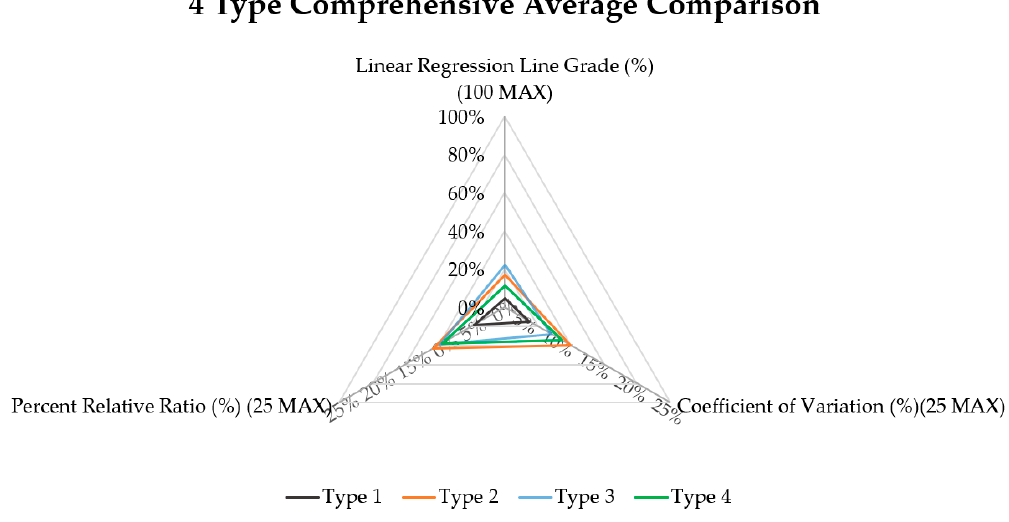
Figure 14. The 4 types comprehensive adhesion stability evaluation of NHV-SPRG.